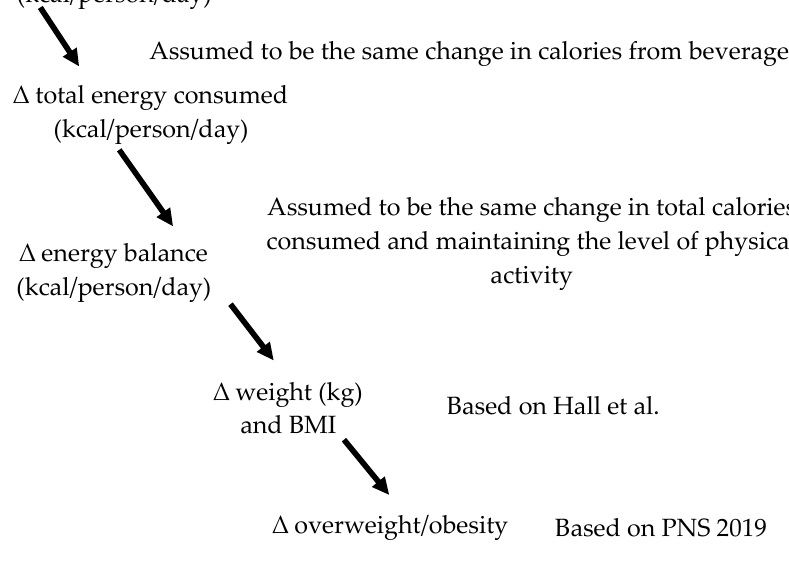
Figure 1. Modeled causal pathway between SSB taxation and overweight/obesity.